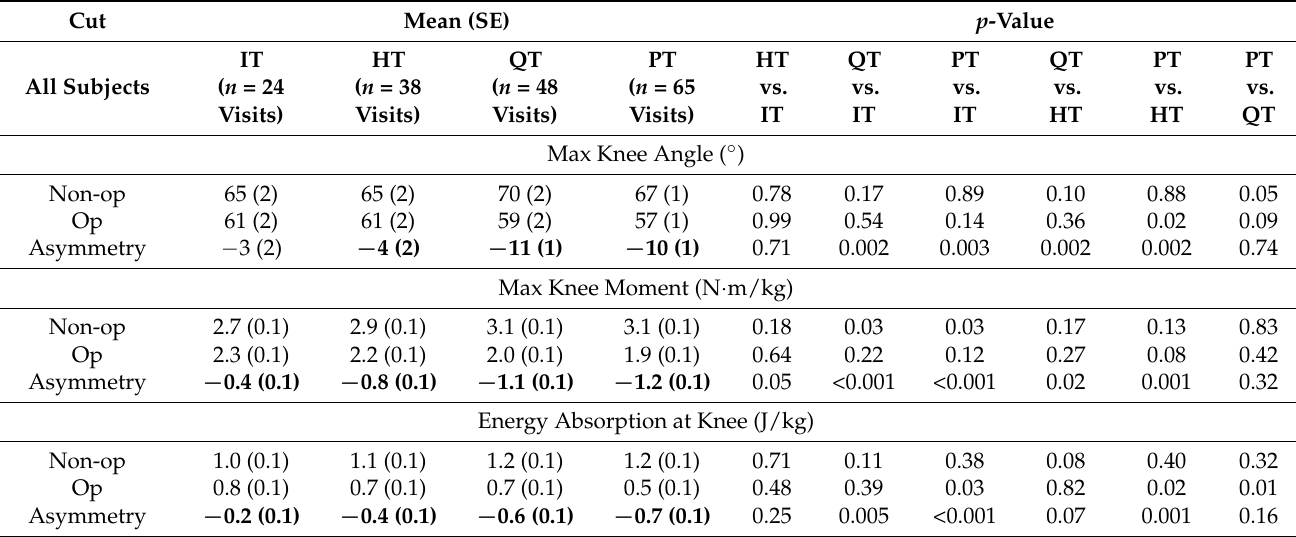
Table 3. Comparison of sagittal knee kinematics/kinetics for operative and non-operative limbs during cutting for complete